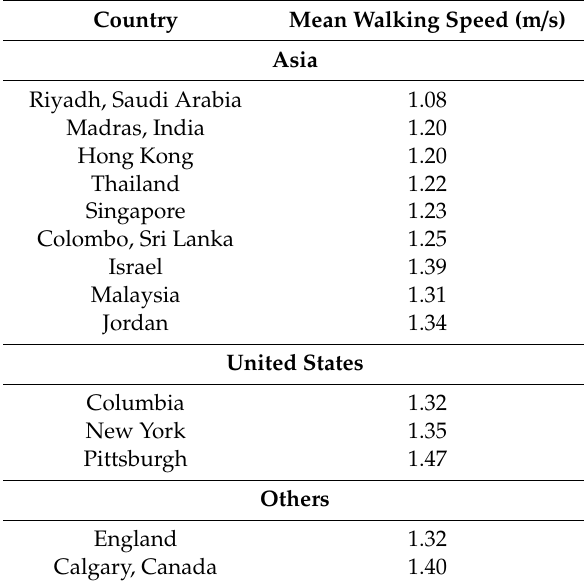
Table 1. Mean speed in di ff erent countries